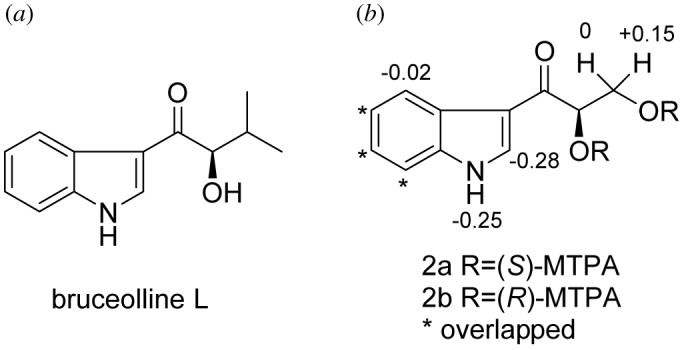
The structures of bruceolline L and Δδ (δS −δR) values for MTPA esters of 2a and 2b in CDCl3.